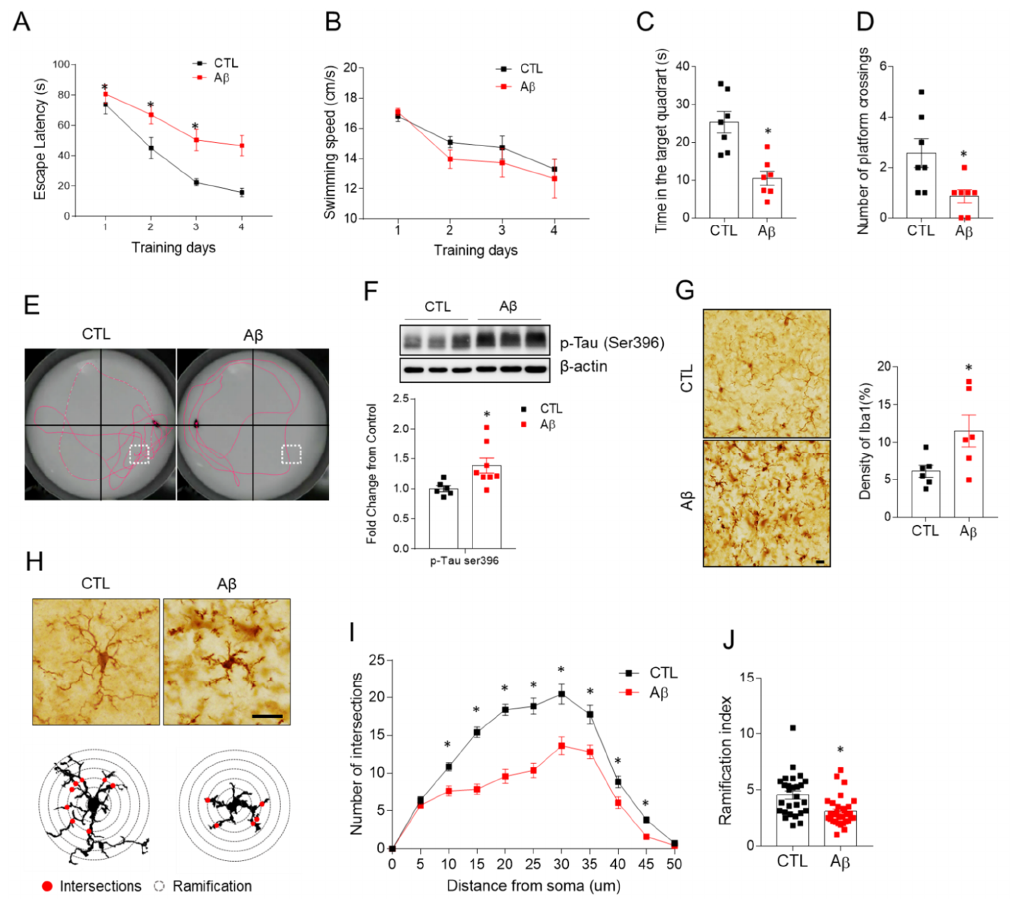
Figure 2. Effects of A β O toxicity on memory deficits, hippocampal tau phosphorylation and microglia activation. The Morris water maze test in control and A β -treated mice at 34 weeks. ( A ) Escape latency and ( B ) average time spent in swimming speed over 4 days. ( C ) Time spent in the target quadrant, and ( D ) number of crossings over the platform area for the three time slices analyzed. ( E ) Representative swimming paths during the probe trail. ( F ) Western blot and quantified hippocampal phosphorylated tau (s396) expression. To normalize total protein level, β -actin was used as a loading control. ( G ) Representative images of Iba-1 immunohistochemistry and quantification of relative optical density (ROD) measurements (%) in hippocampal CA1 regions. Bar = 10 µ m ( H ). The schemes graphically illustrate Sholl analysis of microglia morphology detects. (Red circles indicate Sholl intersections. Circle lines indicate Sholl sphere radius). ( I ) Average number of intersections at specified distances from the soma in microglia, and ( J ) Shoenen ramification index; 27 to 31 cells per region of n = 4 mice. Data are mean ± SEM. * p < 0.05 for control compared with A β -treated